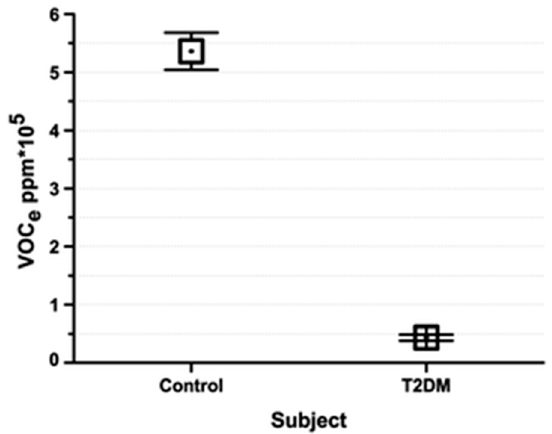
Figure 20. Comparison of the averaged volatile organic compounds (VOCs) as a ppm CO 2 equivalents (VOCe), which is a measure of VOCs as ppm CO 2 equivalents provided by the MOS sensor, in control vs. diabetic (T2DM) subjects. Measurements are from the 30-s pre-test interval. Used with permission from [109].